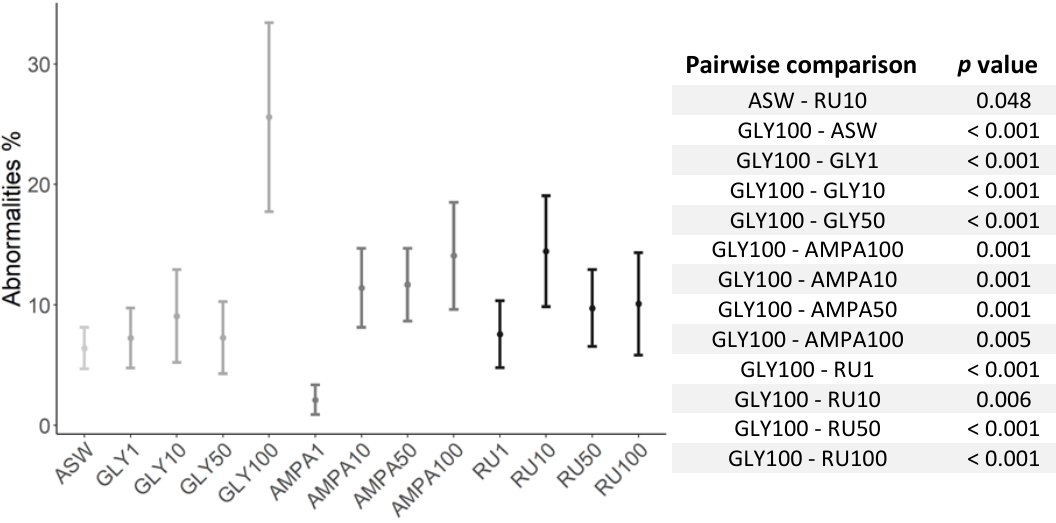
Figure 4. Percentage of abnormalities at 48 hpf in larvae reared in control conditions (ASW) and in four concentrations (1, 10, 50, 100 µ g / L) of three contaminants: glyphosate (GLY), AMPA and Roundup (RU). Values are means ± s.e., n = 6–9. Statistically significant pairwise comparisons are reported in the table on the